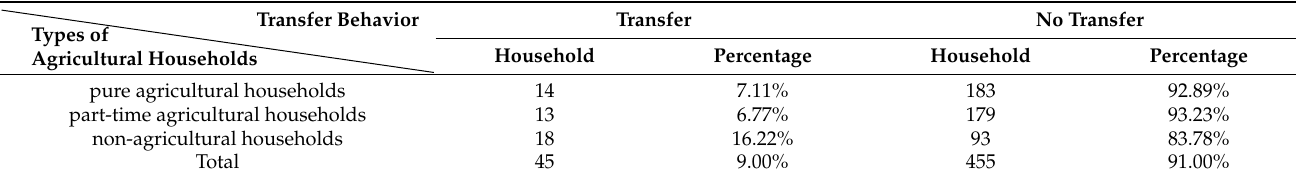
Table 3. Situation of different types of agricultural households’ forestland transfer.